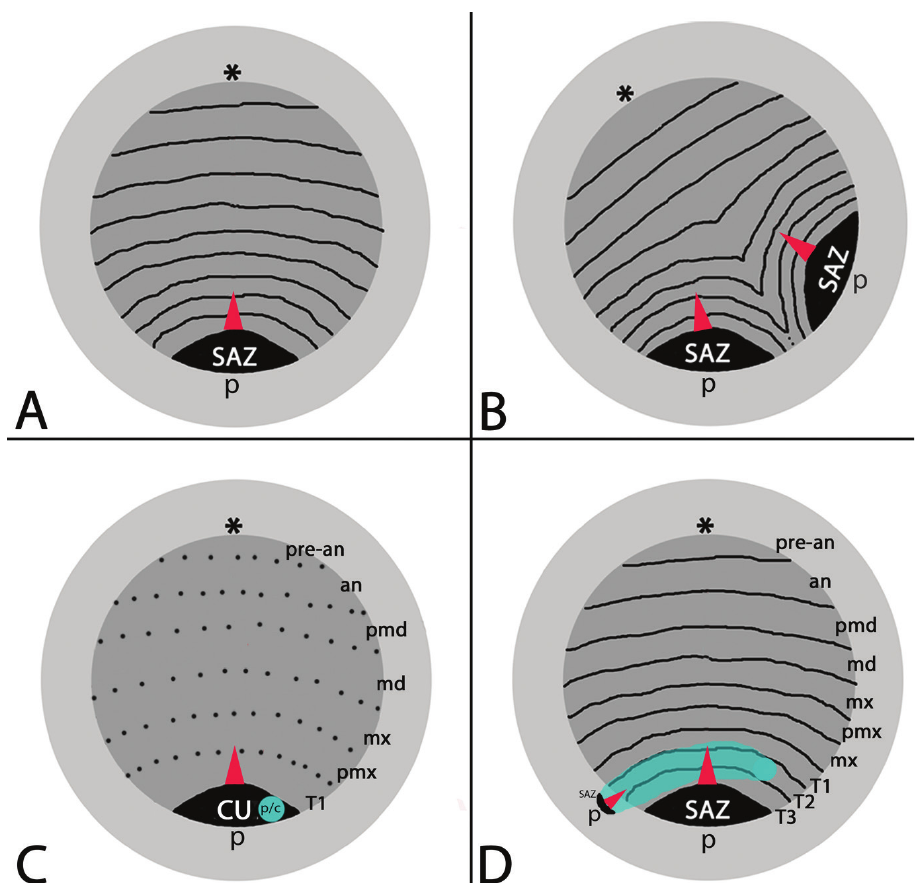
Figure s2. Schematic representation of normal development ( A ), ‘normal’ D. posterior type develop- ment ( B ), and the rare modified case of D. posterior reported in this paper ( C/D ). Light grey: yolk; dark grey: (major) germ band; transverse black lines: segmental boundaries; dashed lines: future segmen- tal boundaries; light blue: minor germ band. Asterisks mark the anterior pole. Red arrowhead point to the direction in which new segments are added from the segment addition zone (SAZ). Abbreviations: an antennal segment; c cumulus of minor germ band; cu cumulus of major germ band; md mandibular segment; mx maxillary segment; p/c posterior (p) end of minor germ band and cumulus (c); pmd pre- mandibular segment; pmx, postmaxillary segment; pre-an pre-antennal area; SAZ segment addition zone; T1-T3 first to third trunk